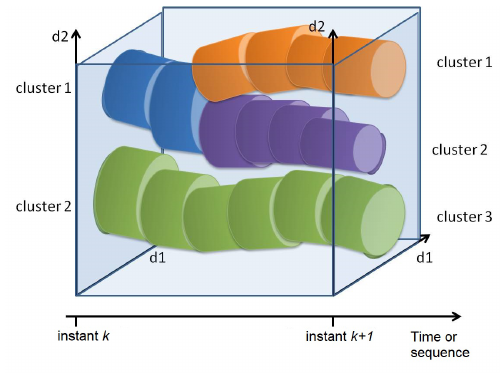
Figure 3. Example of type 3 dynamic clustering.